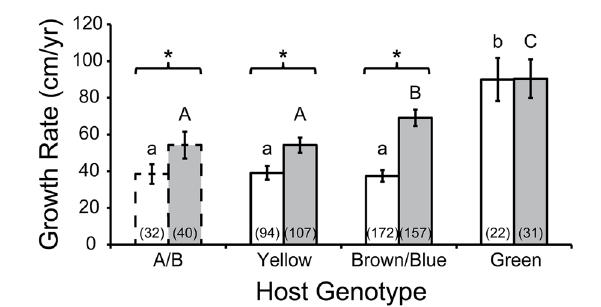
FIGURE 2 | Acropora cervicornis colony growth as a function of host genotype. The Green host genotype had higher growth rates (cm/year) then genotypes A/B,Yellow, and Brown/Blue in shallow water (white bars; similar growth rates indicated by common lower case letters,Tukey’s HSD; p < 0.05) and in deep water (gray bars, similar growth rates indicated by common upper case letters,Tukey’s HSD; p < 0.05). Growth rates were usually higher in deep compared to shallow colonies of a given genotype (asterisks: t -test; p < 0.05). Numbers in parentheses indicate sample size (number of colonies). Error bars depict 95% confidence intervals. Host A/B is bordered by dashed lines to emphasize that for this particular holobiont, the corresponding Symbiodinium “fitti” strain was distinct from the strain that was common to the other three holobionts. Data reanalyzed from Griffin etal.